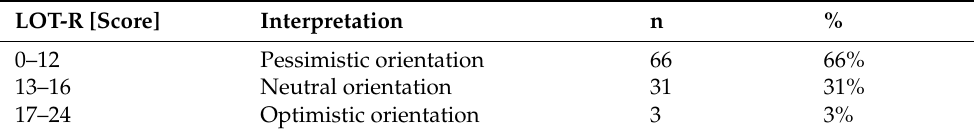
Table 5. The analysis of the LOT-R